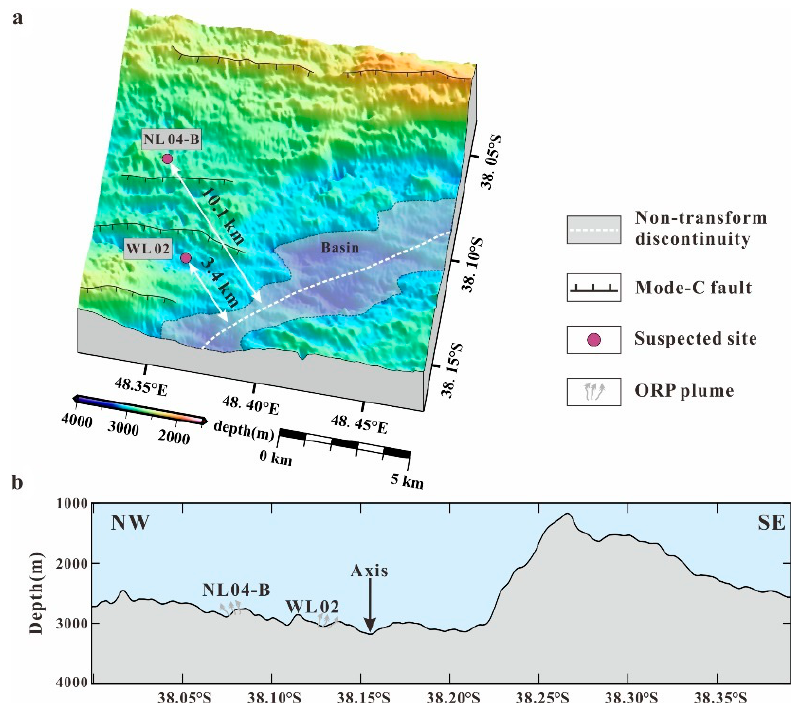
Figure 9. Distribution of hydrothermal anomaly sites for northwest flank of the eastern NTD. ( a ) Distribution of hydrothermal anomaly sites in three-dimensional view. The transparent area indicates an axial basin. ( b ) Distribution of hydrothermal anomaly sites in schematic profile perpendicular to the ridge axis.